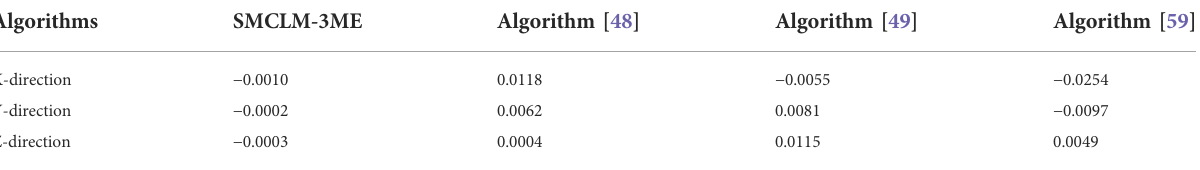
TABLE 5 Correlation coef fi cients comparison.